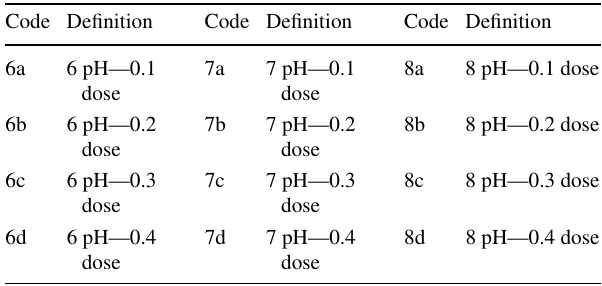
Table 1 Codes and their respective